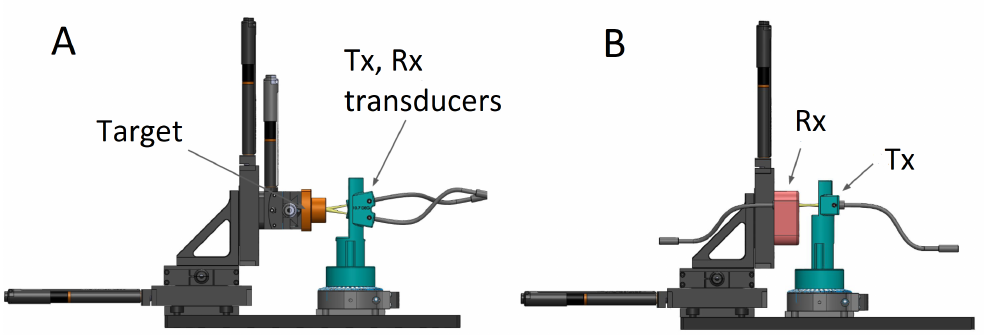
Figure 2. CAD schema for attenuation ( A ) and directionality ( B ) test benches. Tx refers to transducer in transmit mode, Rx receive mode. In A the transducers are fixed and the target is moved. In B the Rx is fixed and the Tx rotated.